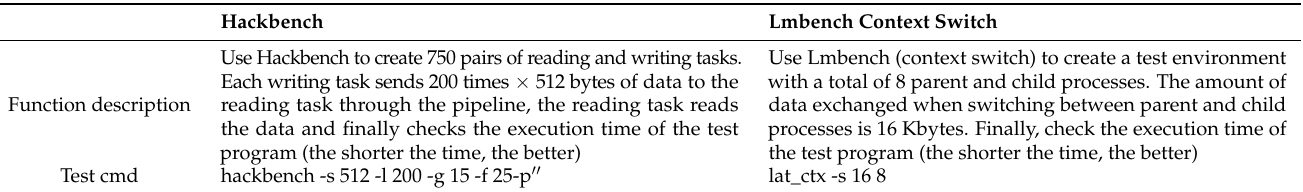
Table 3. Hackbench and Lmbench context